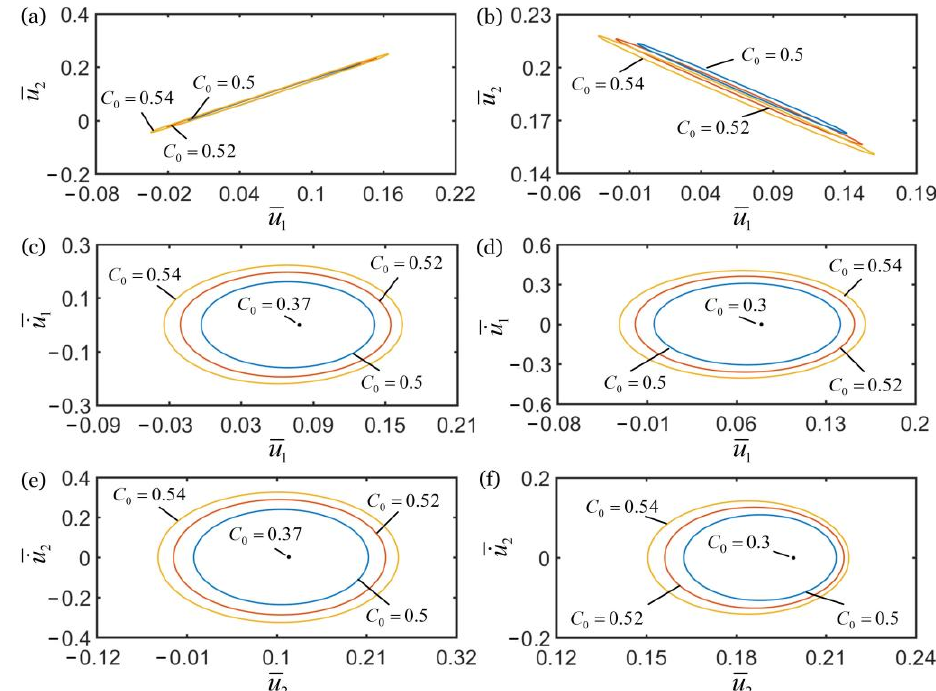
Figure 9. The effect of contraction coefficient C 0 on self-oscillations of the two coupled oscillators. ( a ) Domain of attraction, and ( c , e ) limit cycles for in-phase regime of k 2 = 16. ( b ) Domain of attraction, and ( d , f ) limit cycles for anti-phase regime of k 2 = 4.5. In the computation, the other geometric and material parameters are given in Table 2. With the increase of C 0 , the amplitudes of self-oscillations of two coupled oscillators